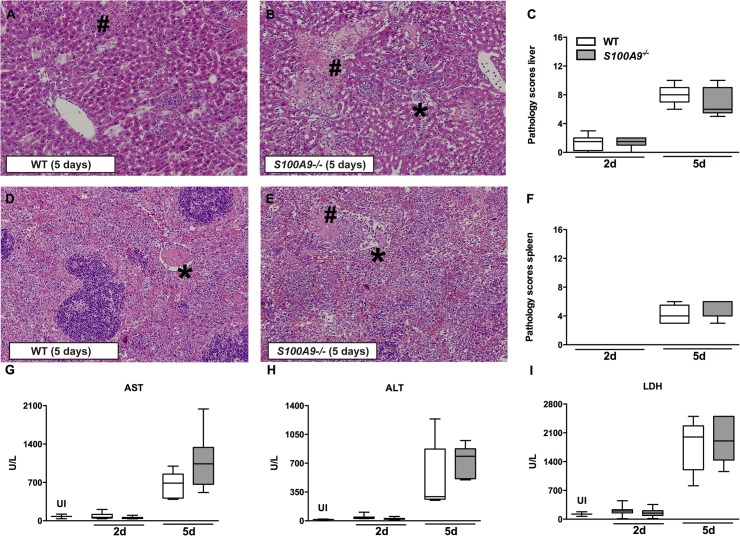
No effect of S100A8/A9 deficiency on organ injury during S. Typhimurium infection.Representative slides of liver (A, B) and spleen (D, E) hematoxylin and-eosin (HE) staining of wildtype (WT) and S100A9
-/- mice, 5 days post infection. Liver and spleen from both WT and S100A9
-/- mice displayed advanced inflammation with necrosis (#) and thrombosis (*). Magnification 10 ×. Total pathology score was determined at indicated time points in WT (white bars) and S100A9
-/- (grey bars) mice according to the scoring system described in the methods section (C, F). Aspartate aminotransferase (AST; G), alanine aminotransferase (ALT; H), and lactate dehydrogenase (LDH; I) were measured in plasma. Data are expressed as box-and-whisker diagrams depicting the smallest observation, lower quartile, median, upper quartile and largest observation (5–8 mice per group at each time point).